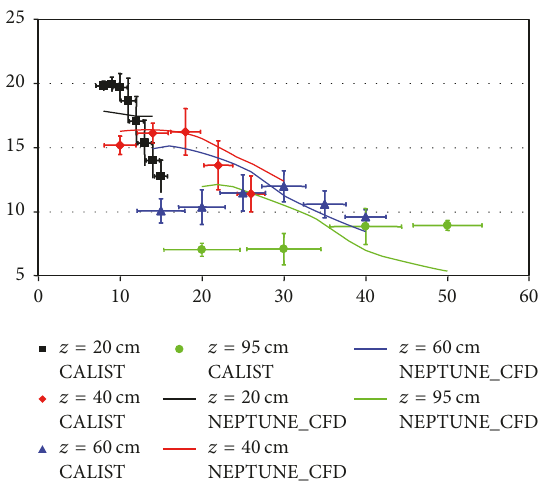
Figure 38: Axial velocity of droplets (m/s) versus radial distance (cm), polydispersed approach.